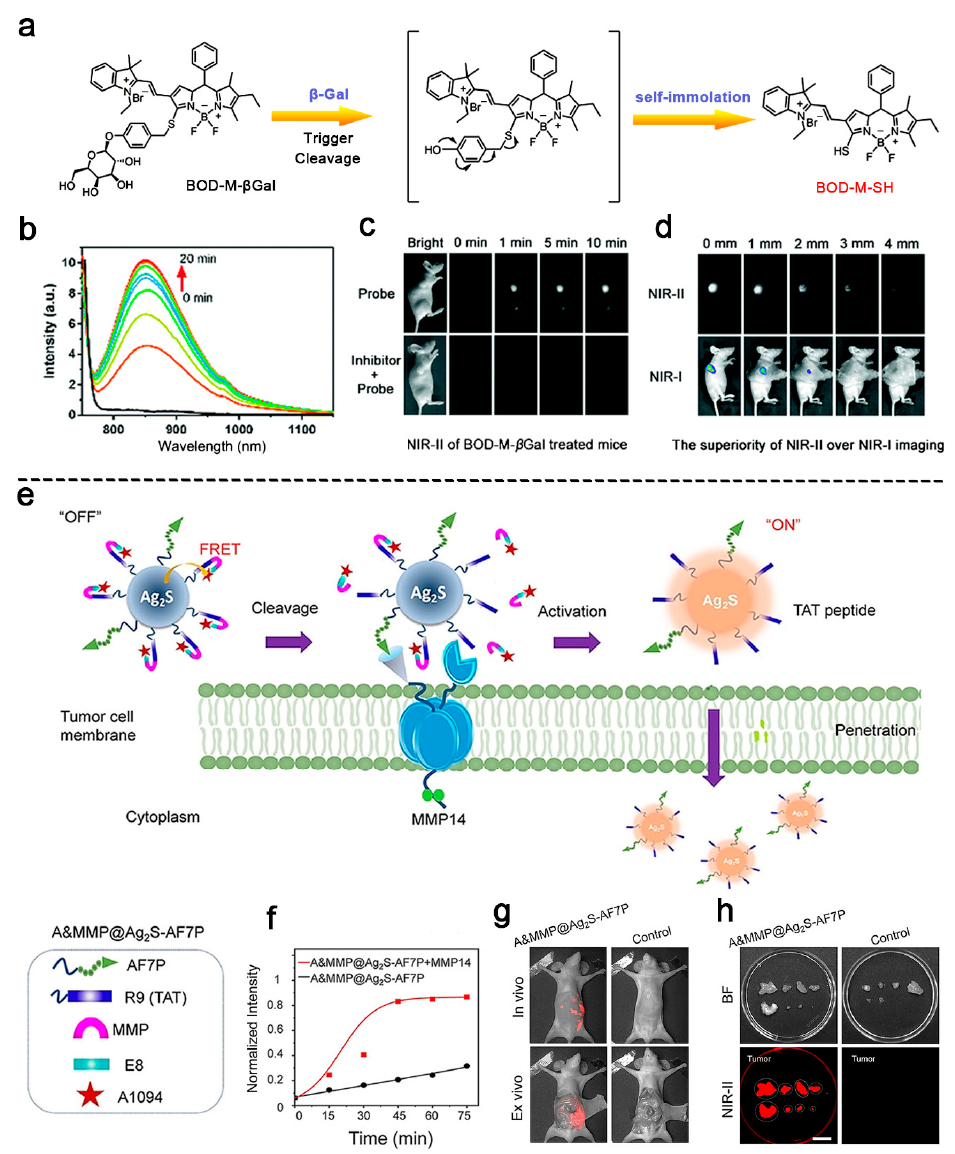
Figure 3. ( a ) Schematic illustration of the mechanism for β -Gal enzymatic activation process of BOD- M- β Gal. ( b ) Time-dependent NIR-II fluorescence spectra of BOD-M- β Gal upon addition of β -Gal in mixed aqueous solution. ( c ) NIR-II fluorescence imaging of mice at different time points after